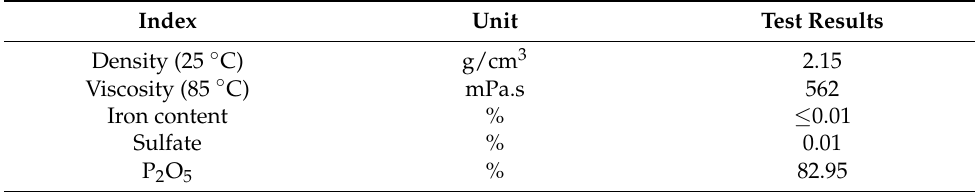
Table 3. The technical indexes of PPA.